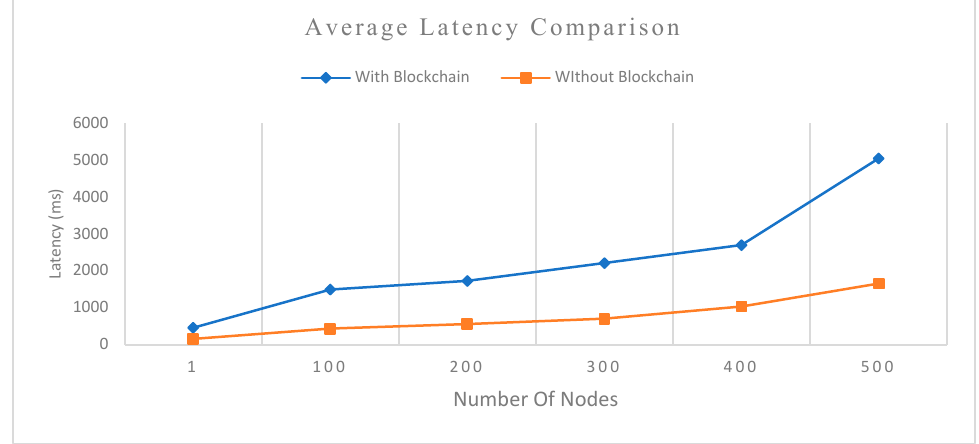
Figure 11. Average latency of VBlock data outsourcing model with and without the blockchain.